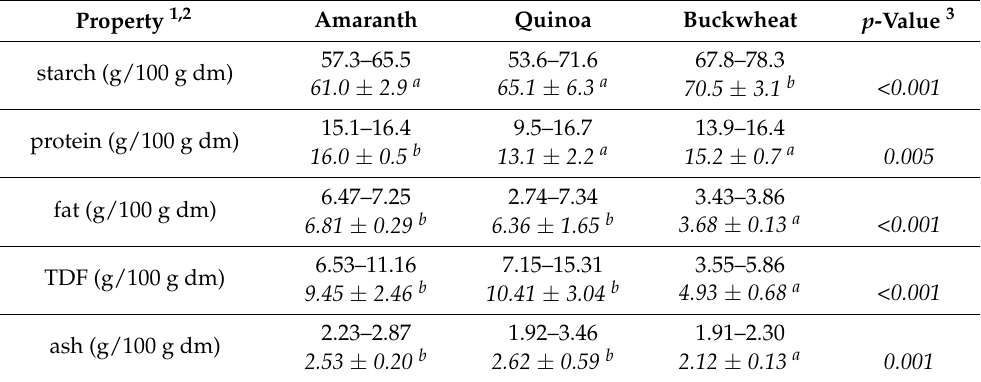
Table 3. Chemical composition of amaranth ( n = 8), quinoa ( n = 7) and buckwheat ( n = 10) whole- meal flour. Property 1,2 Amaranth Quinoa Buckwheat starch (g/100 g